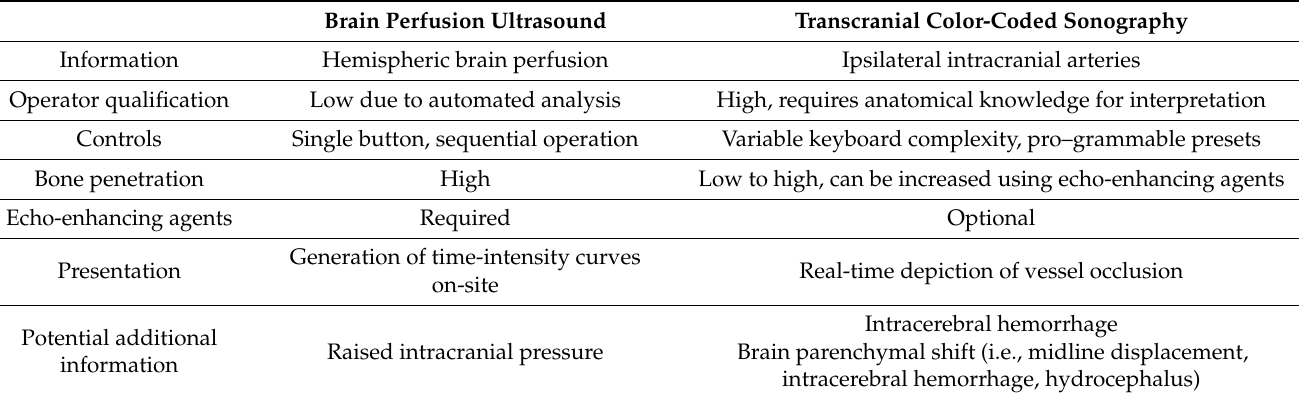
Table 1. Comparison of TCCS and